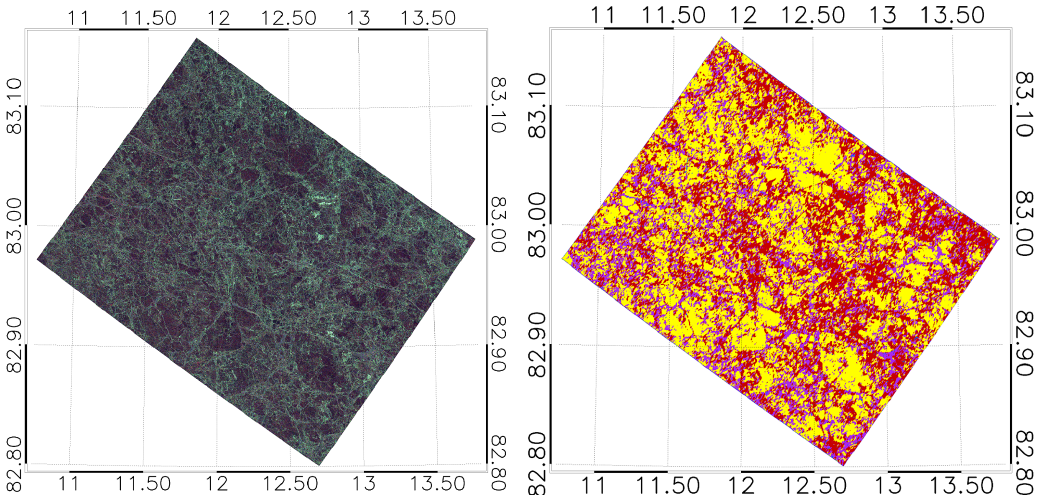
Figure A3. ( Left ) Geocoded Pauli RGB composite (Red: HH-VV Green: HV+VH Blue: HH+VV) of the RS-2 acquisition on 19 April 2015, frame 1; ( Right ) ice classification. Blue: open water/nilas (OW), purple: young ice (YI), yellow: first year ice (SFYI), red: rough first year ice/multi-year ice